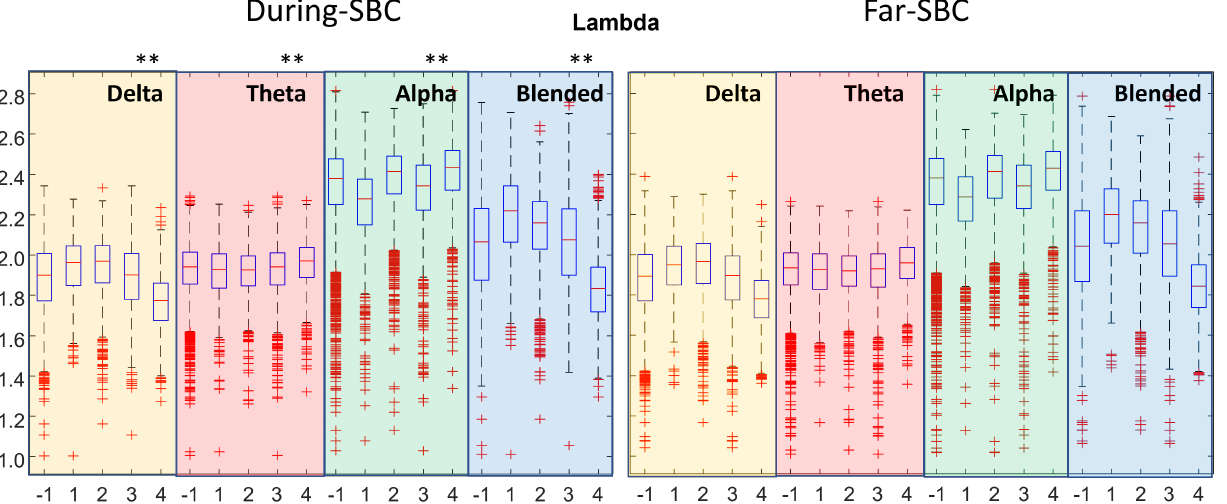
Figure 5. Distribution of lambda, i.e., the characteristic path length of the network (same format as Figure